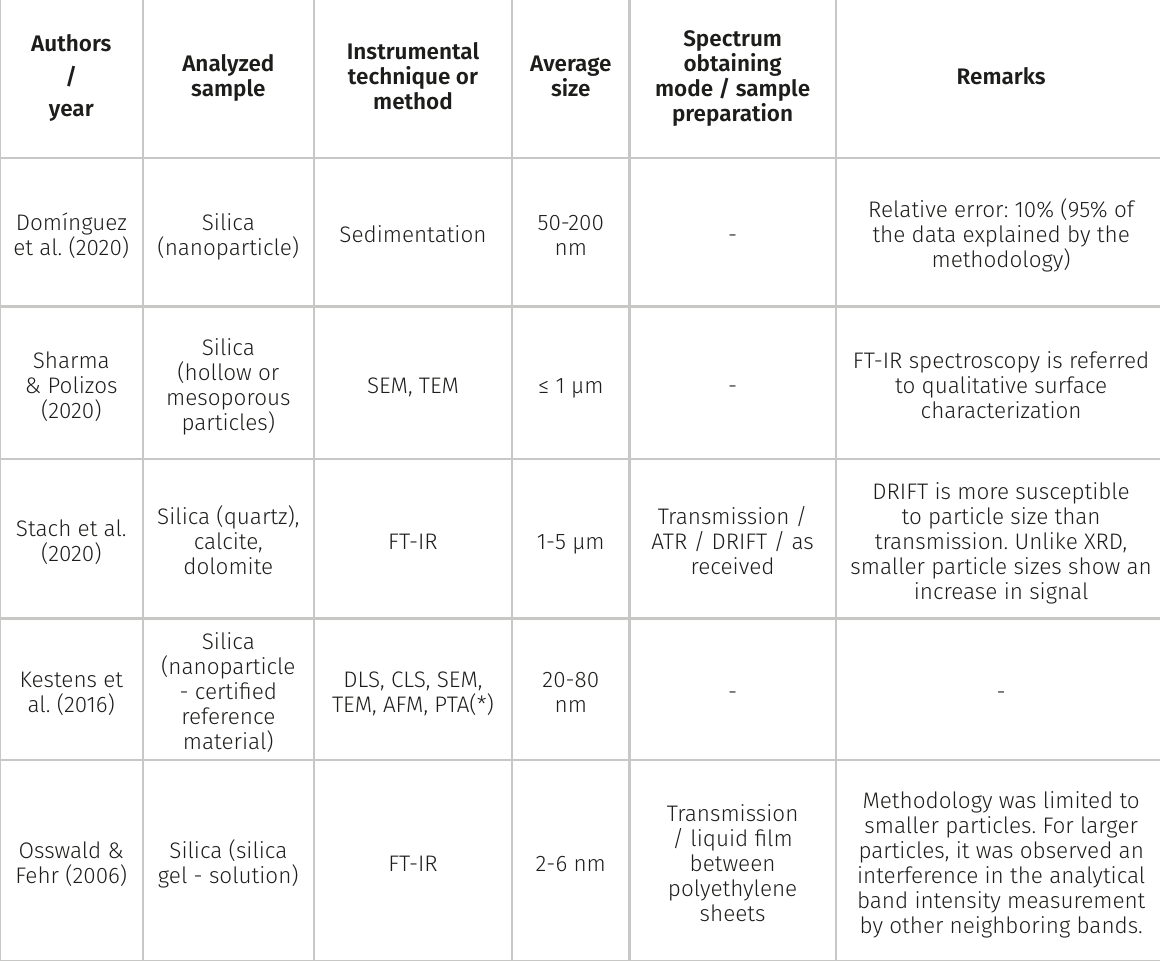
Table I. Literature data on instrumental techniques used in influence evaluation and particle size